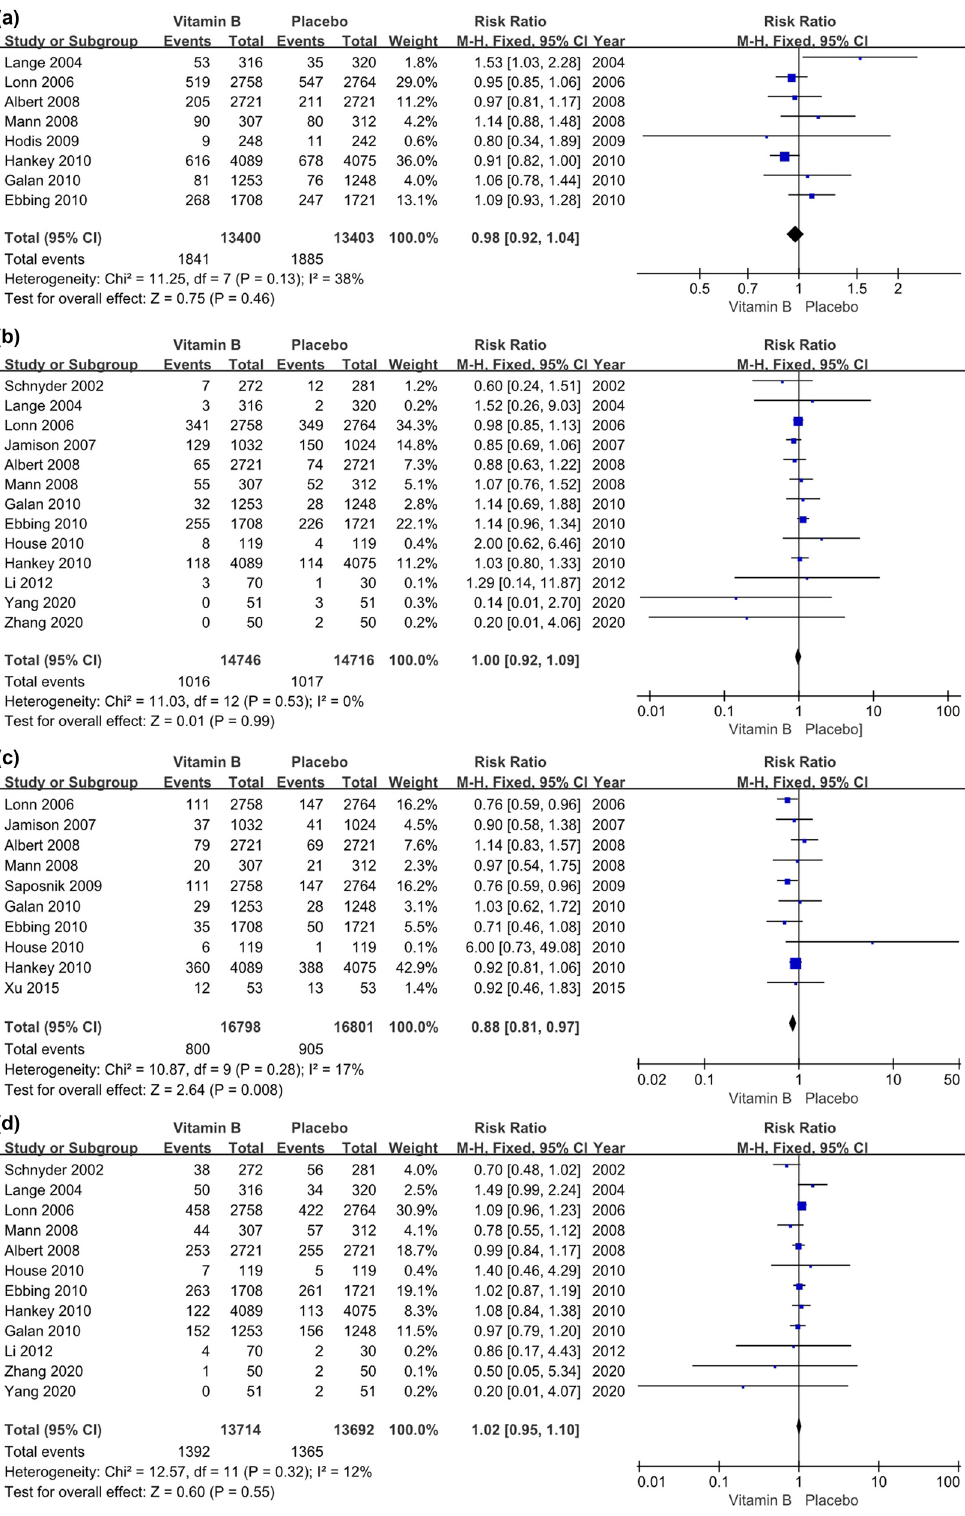
Figure 3: Forest plots showing the e ff ect of B vitamin supplementations on cardiovascular events: ( a ) MACE, ( b ) MI, ( c ) stroke, and ( d )